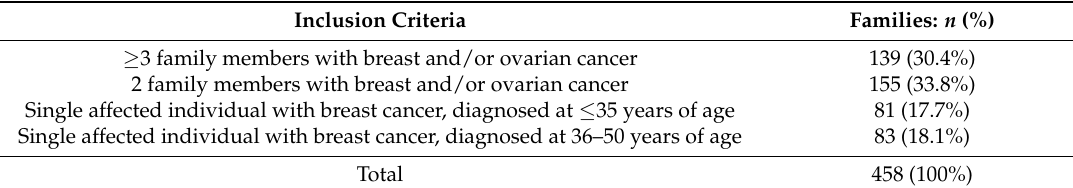
Table 1. Inclusion criteria for